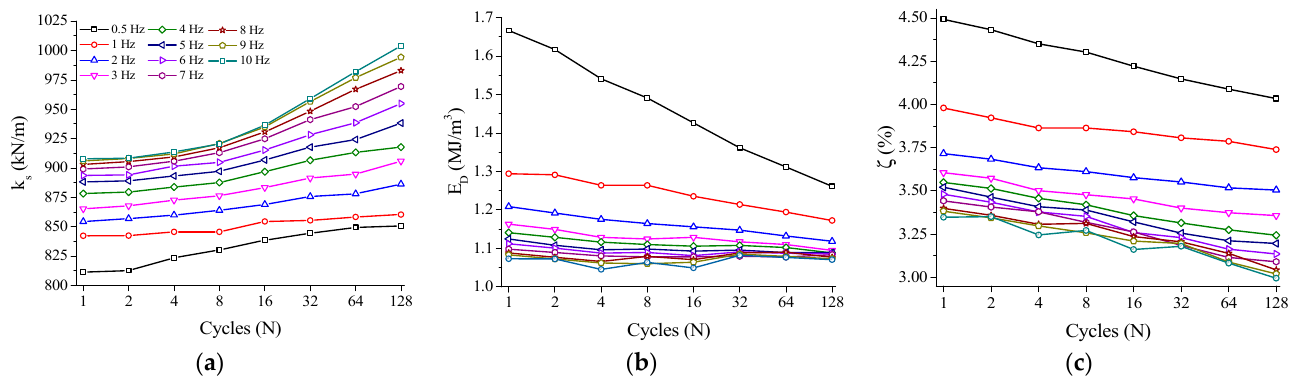
Figure 12. Functional properties over cycles as a function of the load frequencies analyzed. ( a ) Secant stiffness. ( b ) Energy